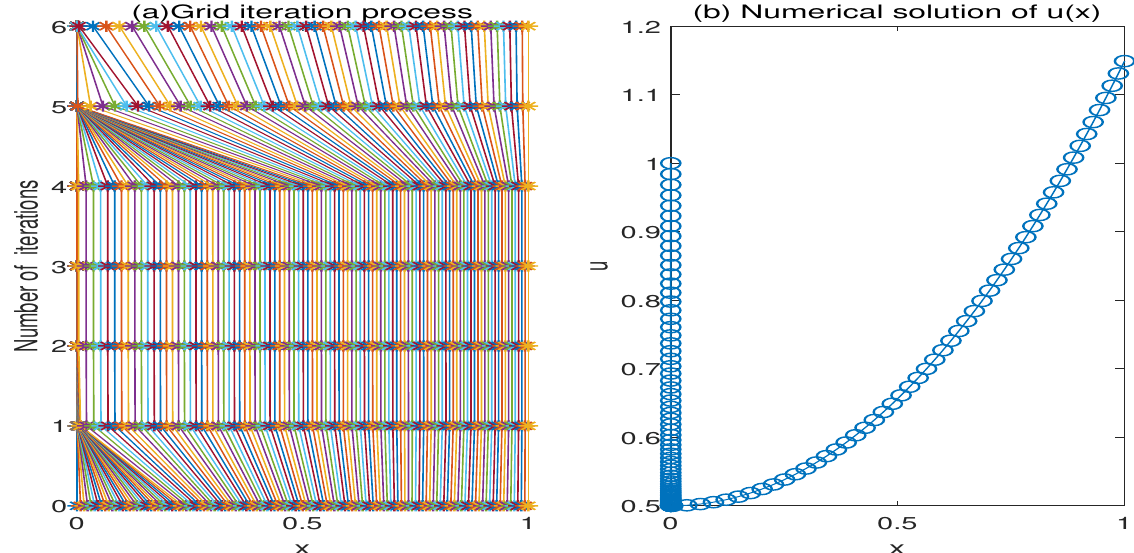
Figure 1. Evolution of the adaptive mesh and numerical solution of Example 1 with ε = 10 − 4 and